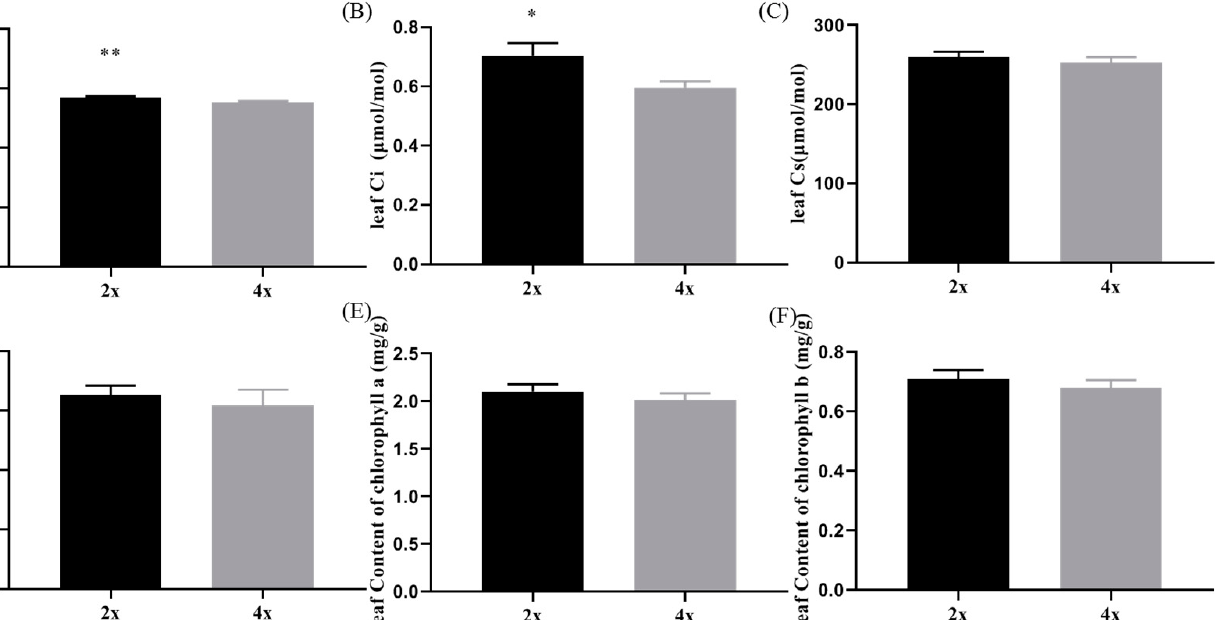
( B ) Ci; ( C ) Cs; ( D ) Tr; ( E ) chlorophyll a content; ( F ) chlorophyll b content. Asterisks indicate Figure 3. Comparison of photosynthetic parameters in diploid and tetraploid watermelon: ( A ) Pn;